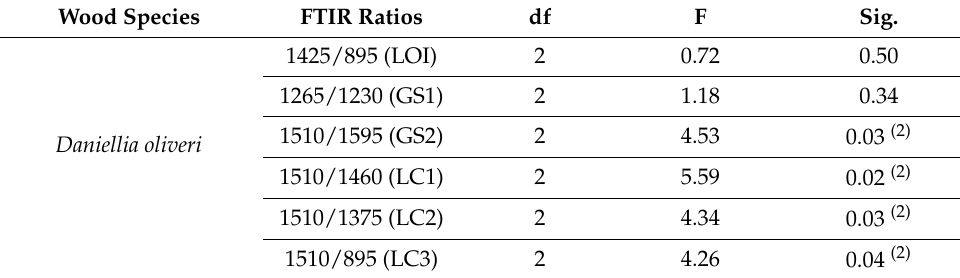
Table 5. Summary of the one-way ANOVA using FTIR ratios. Wood Species FTIR Ratios df F